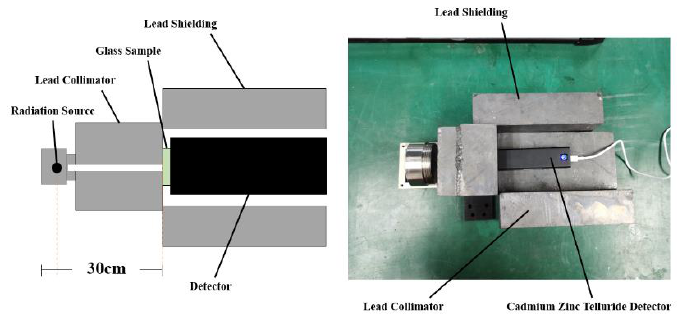
Figure 1. Structure diagram and physical diagram of the radiation shielding measurement device.